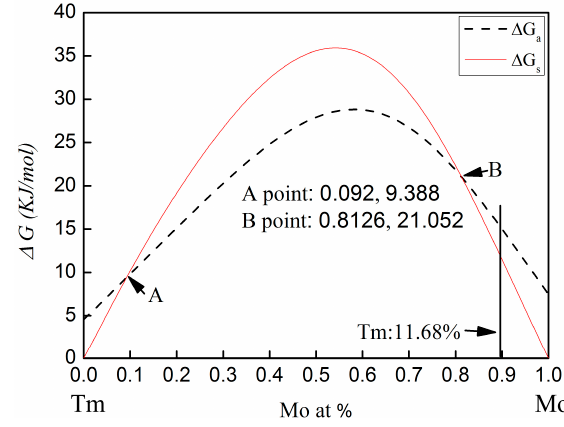
G  and G  are the s a